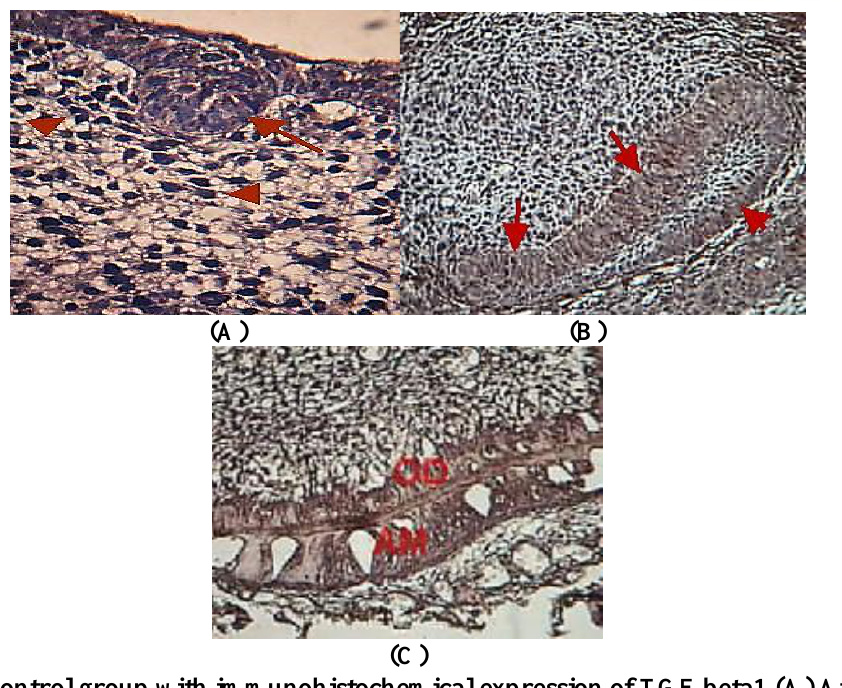
Figure 3: Control group with immunohistochemical expression of TGF beta1 (A) At 16 th day I.U.L upper jaw shows positivity by basal cell of tooth germ (arrow), mesenchymal cell (arrow heads) (X20). (B) At 18th day IUL shows positivity by .Inner enamel epithelial (arrows), outer enamel epithelial (arrow head) in cervical loop (X20).(C) One day old, shows positivity by Odontoblast (OD),ameloblast(AM) (X40).